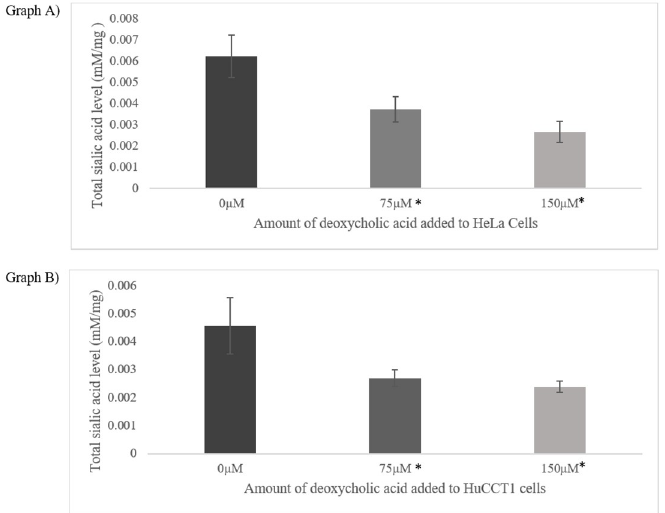
Fig 3. The changes in the total sialic acid level according to various concentration of deoxycholic acid (0 μ M, 75 μ M and 150 μ M) added for HeLa (Graph A) and HuCCT1 (Graph B) cells. The values are mean ± SD, n = 6. The asterisks indicate the total sialic acid level for 75 μ M and 150 μ M were statistically significantly different to the control Neu5Ac level: � P <